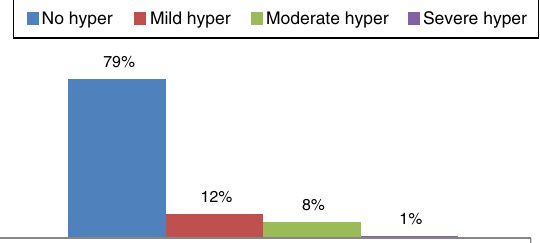
Distribution in percentage of live judgement classi- fication in the four-point scale. Distribution of THYPER scores with binary inter- pretation of the findings and calculation of the percentage indicating absence (without hypernasality) and presence (with hypernasality). THYPER score